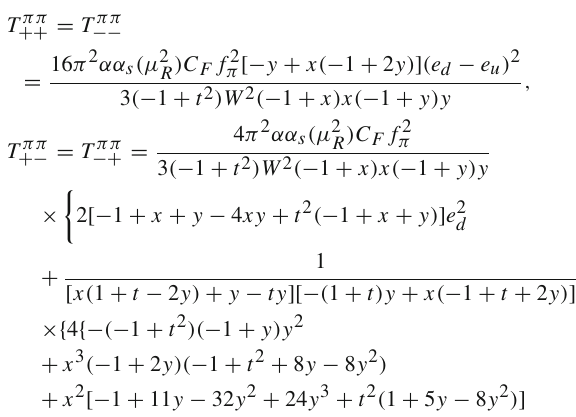
d σ/ d | cos θ | for π + π − , K + K − . The experimental points are from the Belle 0